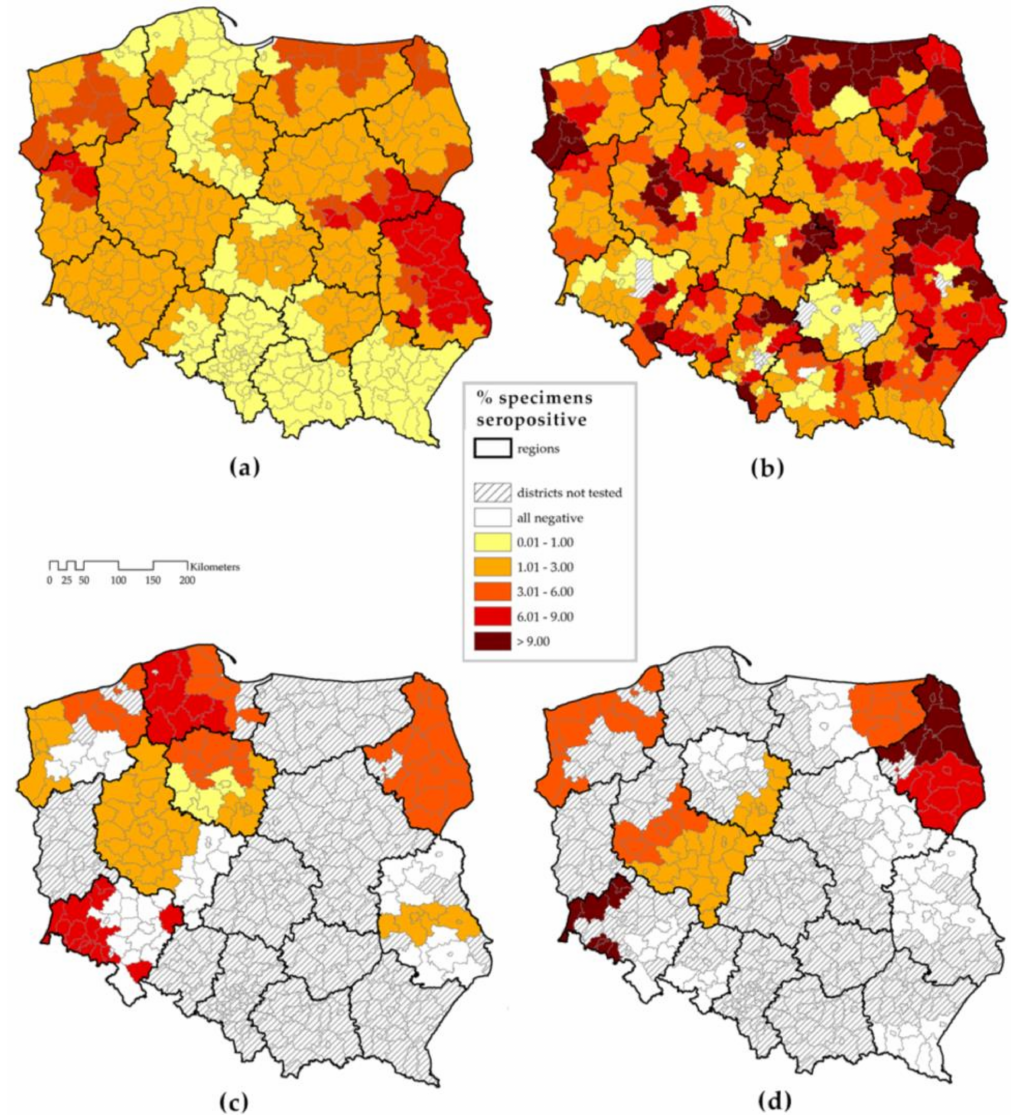
Figure 2. Previous studies of seroprevalence with national coverage at NUTS-4 district level: ( a ) in the years 1965–1967, 17,000 healthy subjects were selected from all districts in Poland, tested by complement fixation test (CFT) [15]; ( b ) in the years 1971–1972, 20,000 foresters were selected from most regions, by ELISA IgG [17]; and ( d ) in the years 2005–2007, 1122 goat sera from selected regions were tested by adapted ELISA IgG [18]. Note: the maps were redrawn based on original figures kept at the National Institute of Public Health, the owner of the